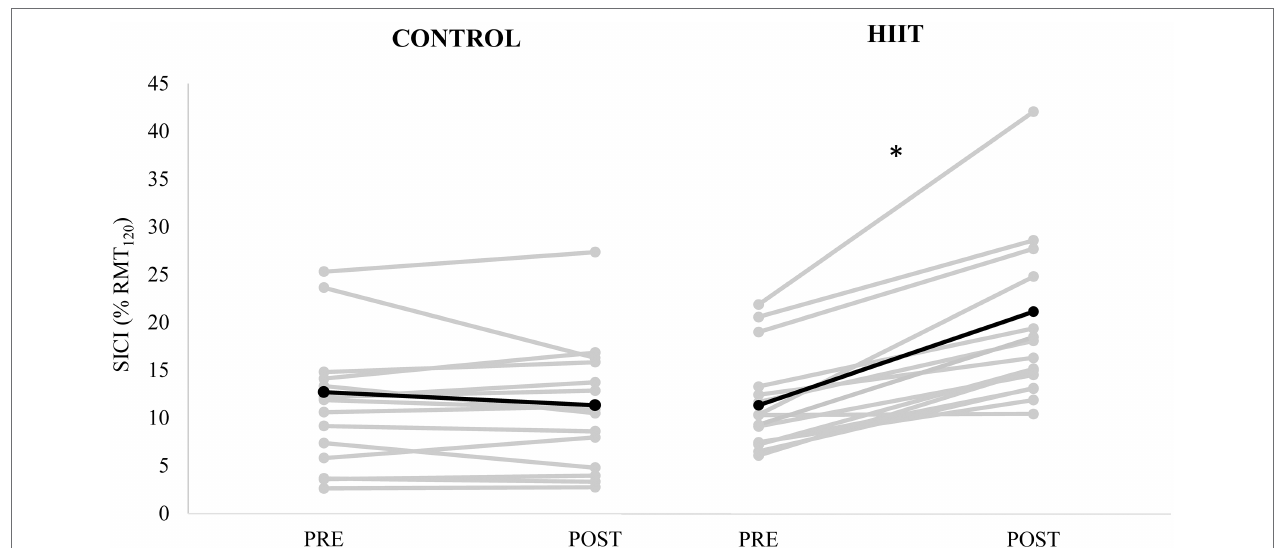
FIGURE 2 | Short-interval intracortical inhibition (conditioned MEP amplitude expressed as % of unconditioned MEP 120 amplitude) measured PRE and POST for each participant (gray lines) with control condition shown in the left panel, and HIIT condition shown on the right panel. The mean for each condition is depicted by the black line. * denotes a significant condition × time interaction ( p = 0.002).